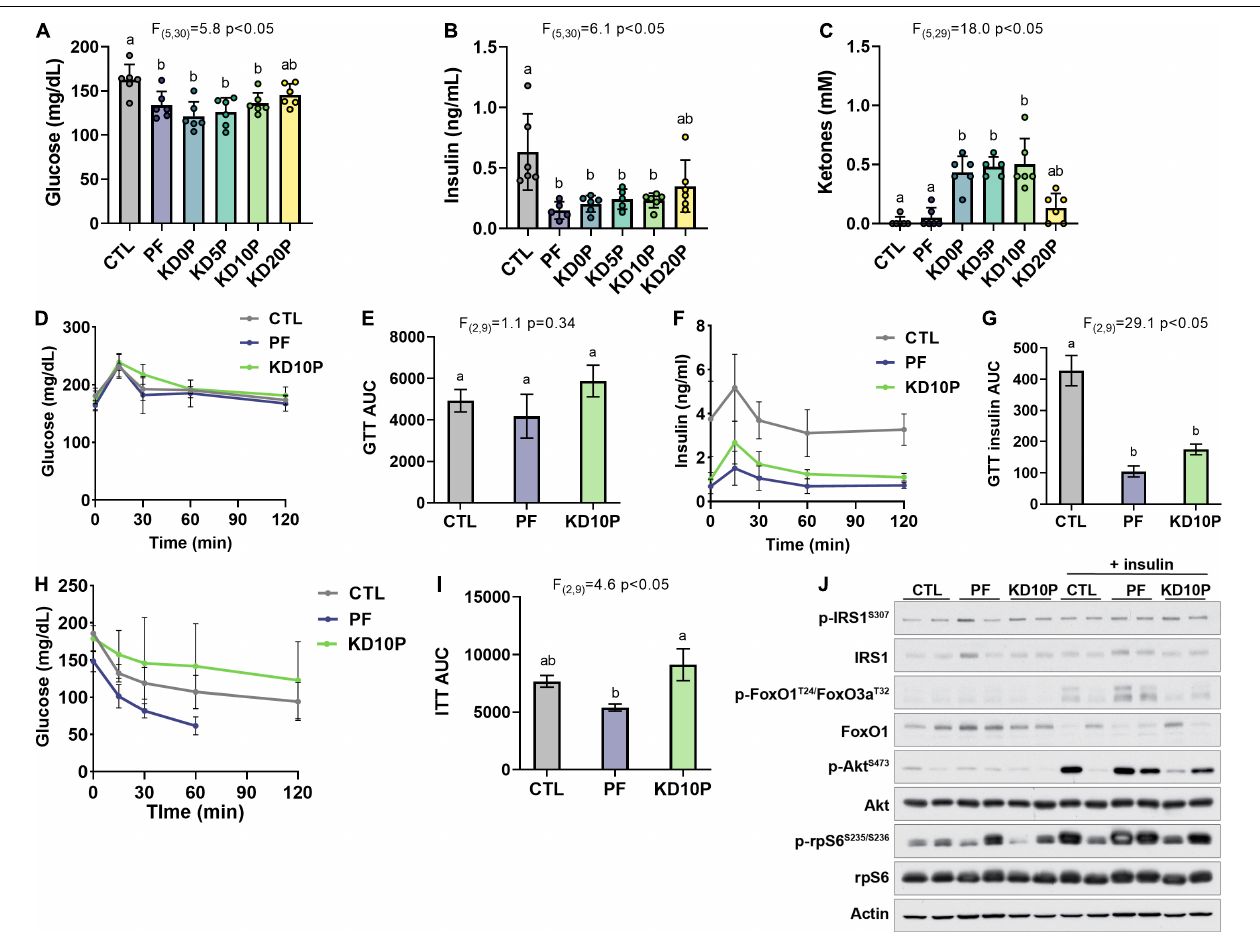
FIGURE 2 | Protein-free, but not ketogenic, diet improves insulin sensitivity following short-term feeding. After 8 days of diet feeding, mice were fasted for 6 h prior to sacrifice ( n = 6 per diet). Blood was collected and blood glucose (A) and ketones (C) were measured with handheld meters. Serum insulin was measured by ELISA (B) . (D) Blood glucose levels during an oral glucose tolerance test (OGTT) in a separate cohort of 6-h fasted mice fed experimental diets for 5 days ( n = 4 per diet) and (E) corresponding area under the curve (AUC). (F) Serum insulin measurements collected during the OGTT and (G) corresponding AUC. (H) Blood glucose levels during an insulin tolerance test in 4-h fasted mice fed experimental diets for 7 days ( n = 4 per diet) and (I) corresponding AUC. Measurements were halted after 60 min in PF-fed mice due to severe hypoglycemia. (J) Mice fed experimental diets for 10 days were fasted for 6 h and then injected intraperitoneally with vehicle or insulin and sacrificed after 20 min. Immunoblots show insulin/Akt/mTORC1 signaling in liver lysates ( n = 2 per diet per treatment). Statistical analysis was performed by one-way ANOVA with Tukey’s multiple comparison test. Different letters indicate significant differences ( p < 0.05) between groups, with common letters indicating no significant difference. Values are represented as mean ±